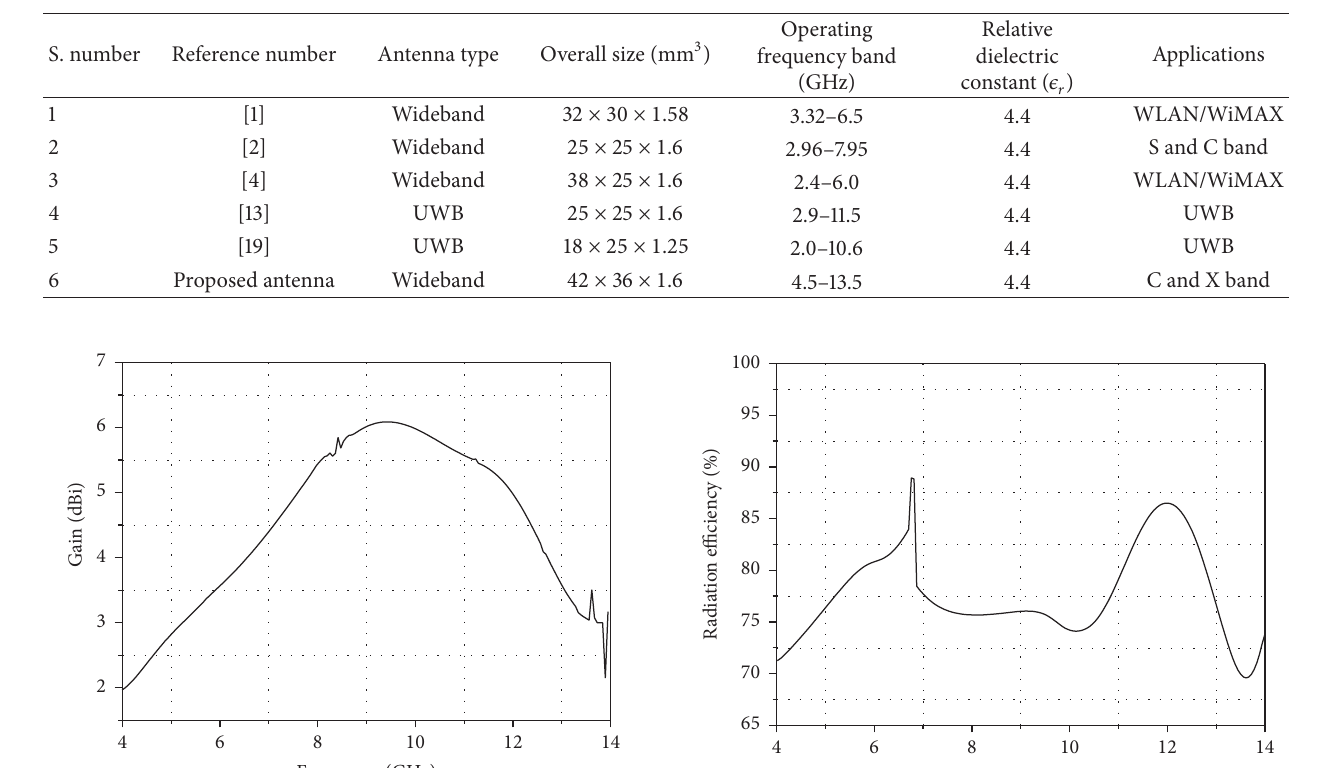
Table 2: Comparison of reference antennas with proposed antenna.